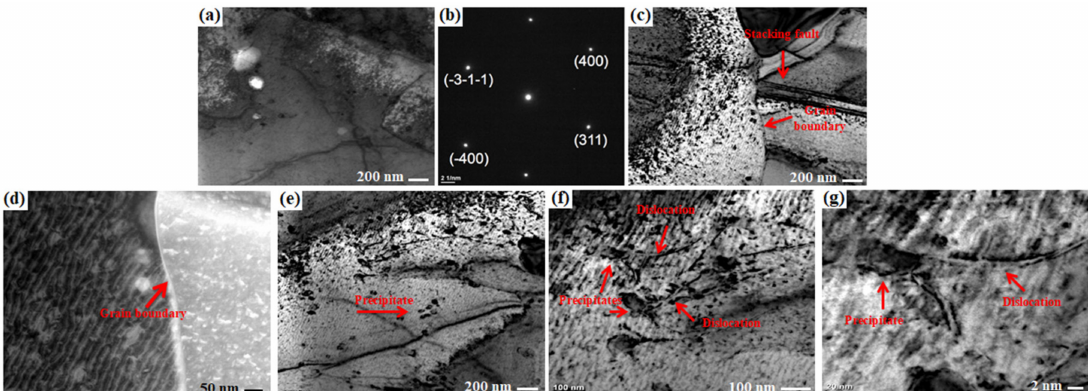
Figure 7. ( a ) TEM image of the selected area diffraction (SAD), ( b ) SAD area, ( c ) recrystallized grain boundary, ( d ) recrystal- lized grain boundary (higher resolution), ( e ) precipitation in the matrix, ( f ) dislocation pile-up around the precipitates and ( g ) dislocation pile-up at the precipitate (higher resolution) of the heat-treated sample at 1200 ◦ C after creep test at 800 ◦ C under 100 MPa